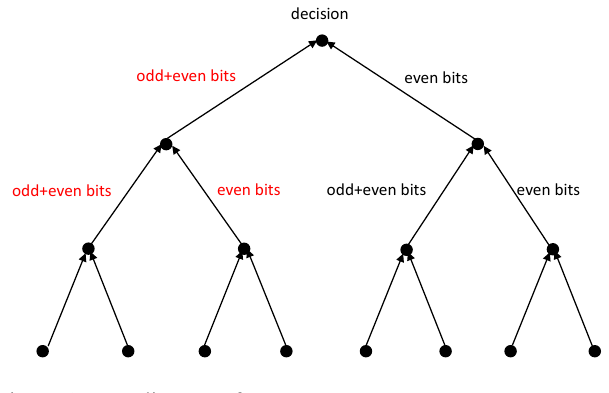
Figure 8 Decoding tree for 𝑁 = 8